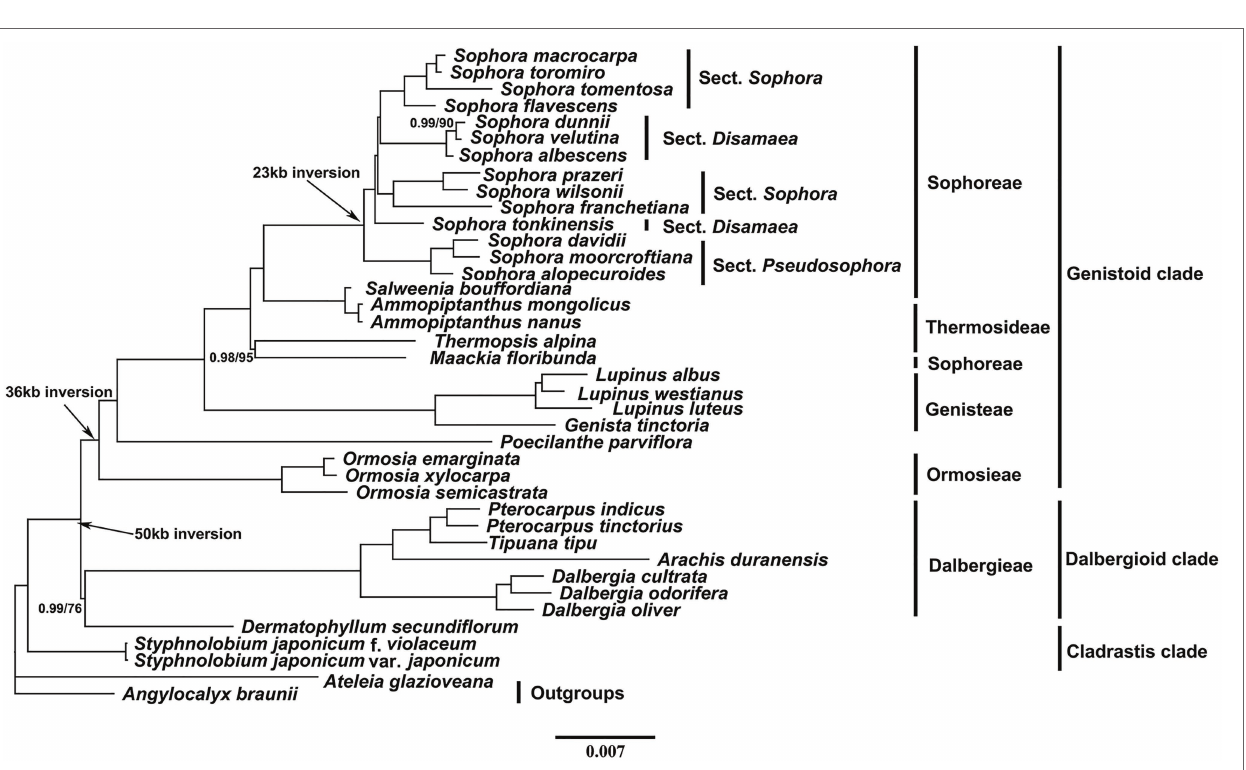
FIGURE 6 | Phylogenetic tree obtained using the Bayesian Inference (BI) method of the plastid genomes of 39 taxa. Numbers above branches indicate Bayesian posterior probabilities (before slash) and ML bootstrap supports (after slash). The full support values are not